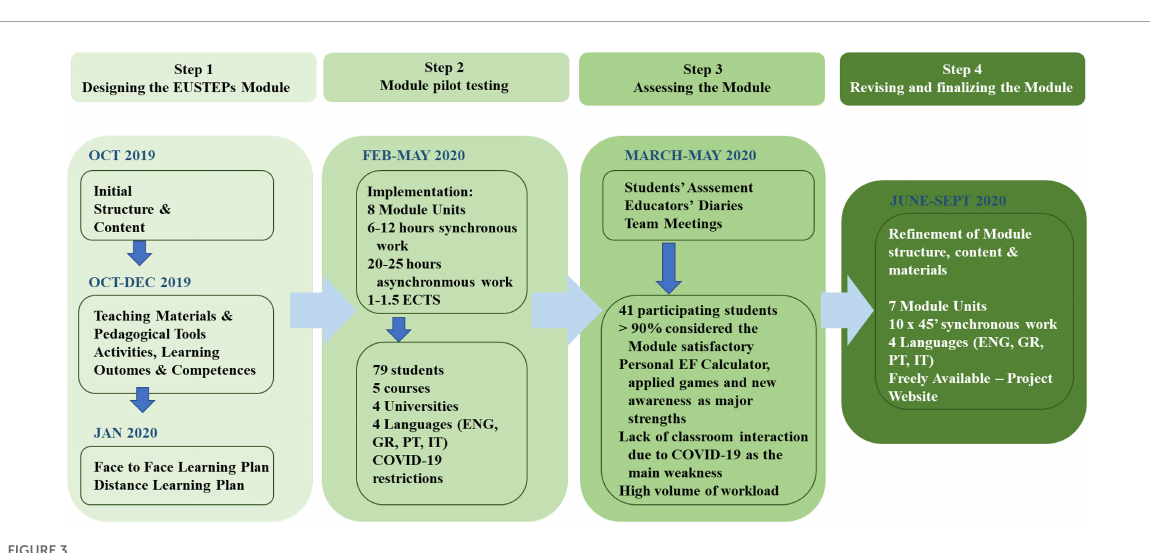
FIGURE3 Overview of the EUSTEPs Module development